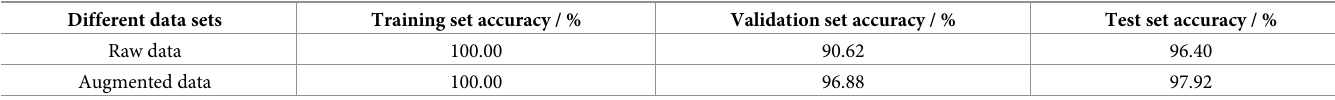
Table 2. Comparison of model accuracy between original and augmented data.